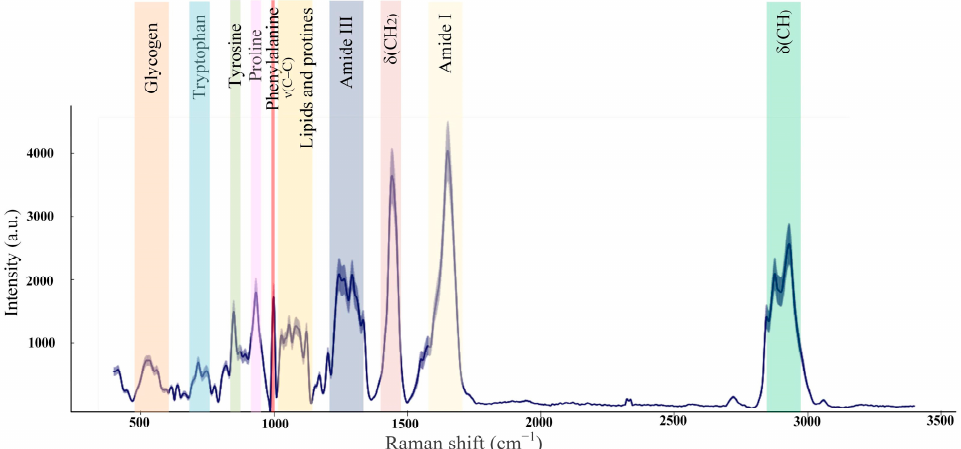
Figure 8. Mice healthy skin average Raman spectra (the number of processed Raman spectra was